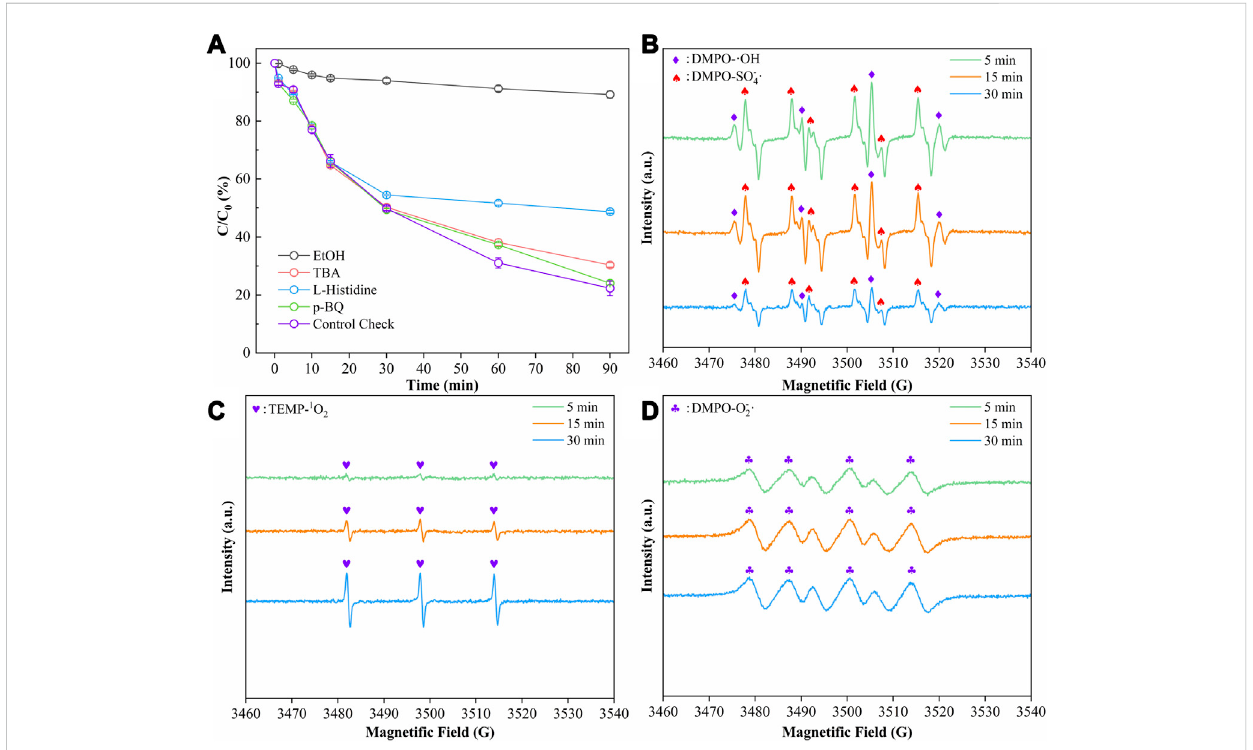
FIGURE 7 (A) The inhibiting effects of different quenching regents on the DMP degradation ef fi ciency (DMP = 10 ppm, pH = 3, PMS = 10 mmol/L, EtOH = 1.2 mol/L,TBA=1.2 mol/L,L-Histidine=10 mmol/L,p-BQ=10 mmol/L);andEPRspectraof (B) SO - 4